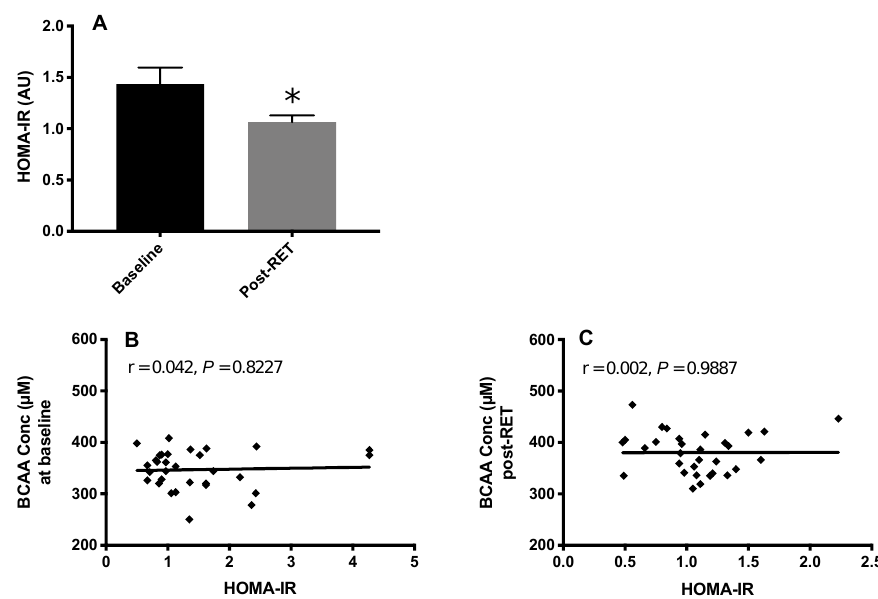
Figure 3. Insulin resistance (via homeostatic model assessment of insulin resistance (HOMA-IR) at baseline and after 20 weeks, fully supervised, whole-body resistance exercise training (RET) ( A ) and the relationship between IR and circulating branched chain amino acid (BCAA) concentrations at baseline ( B ) and after (C) RET. * p < 0.05 vs. baseline.